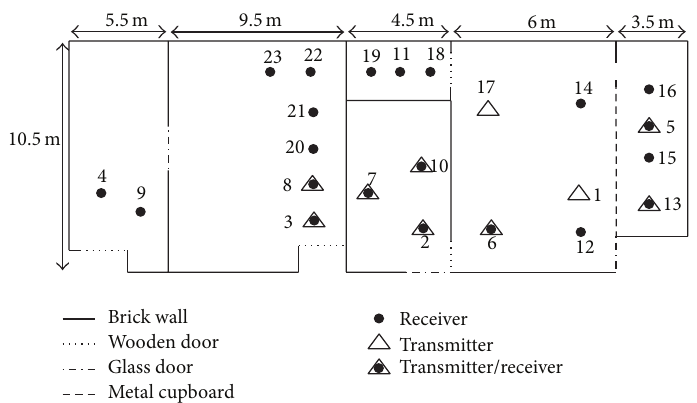
Figure 4: Measurement floor